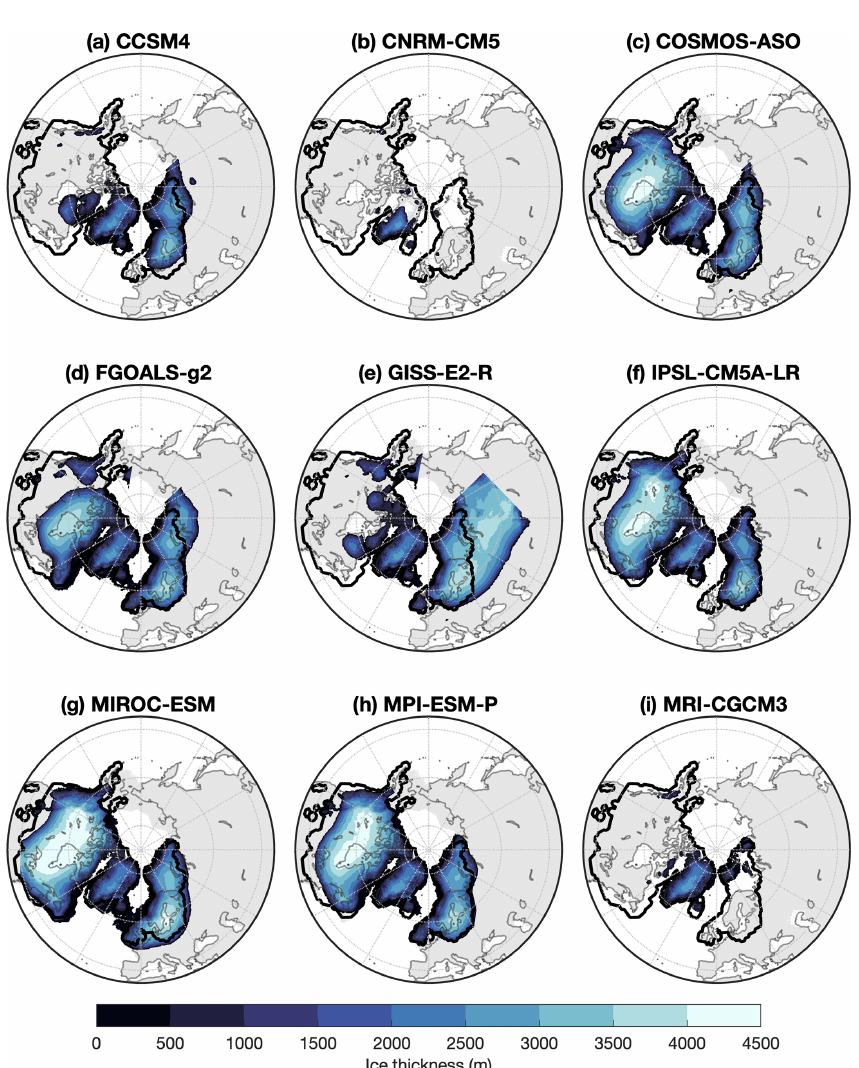
Figure B1. LGM ice thickness of an ice sheet model forced by nine different PMIP3 climates, interpolated using the climate matrix method. Black contours represent the LGM ice sheet reconstruction by Abe-Ouchi et al. (2015).